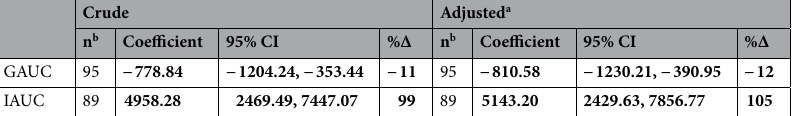
Table 3. Association between WSD and third-trimester GAUC and IAUC among first study pregnancies (n = 95). WSD, western-style diet; CI, confidence interval; GAUC, glucose tolerance test area under the curve; IAUC, insulin area under the curve. a Adjusting for age and parity. b Sample size differs from 95 due to missing IAUC measurement. The bold indicates significantly different values from the reference group.